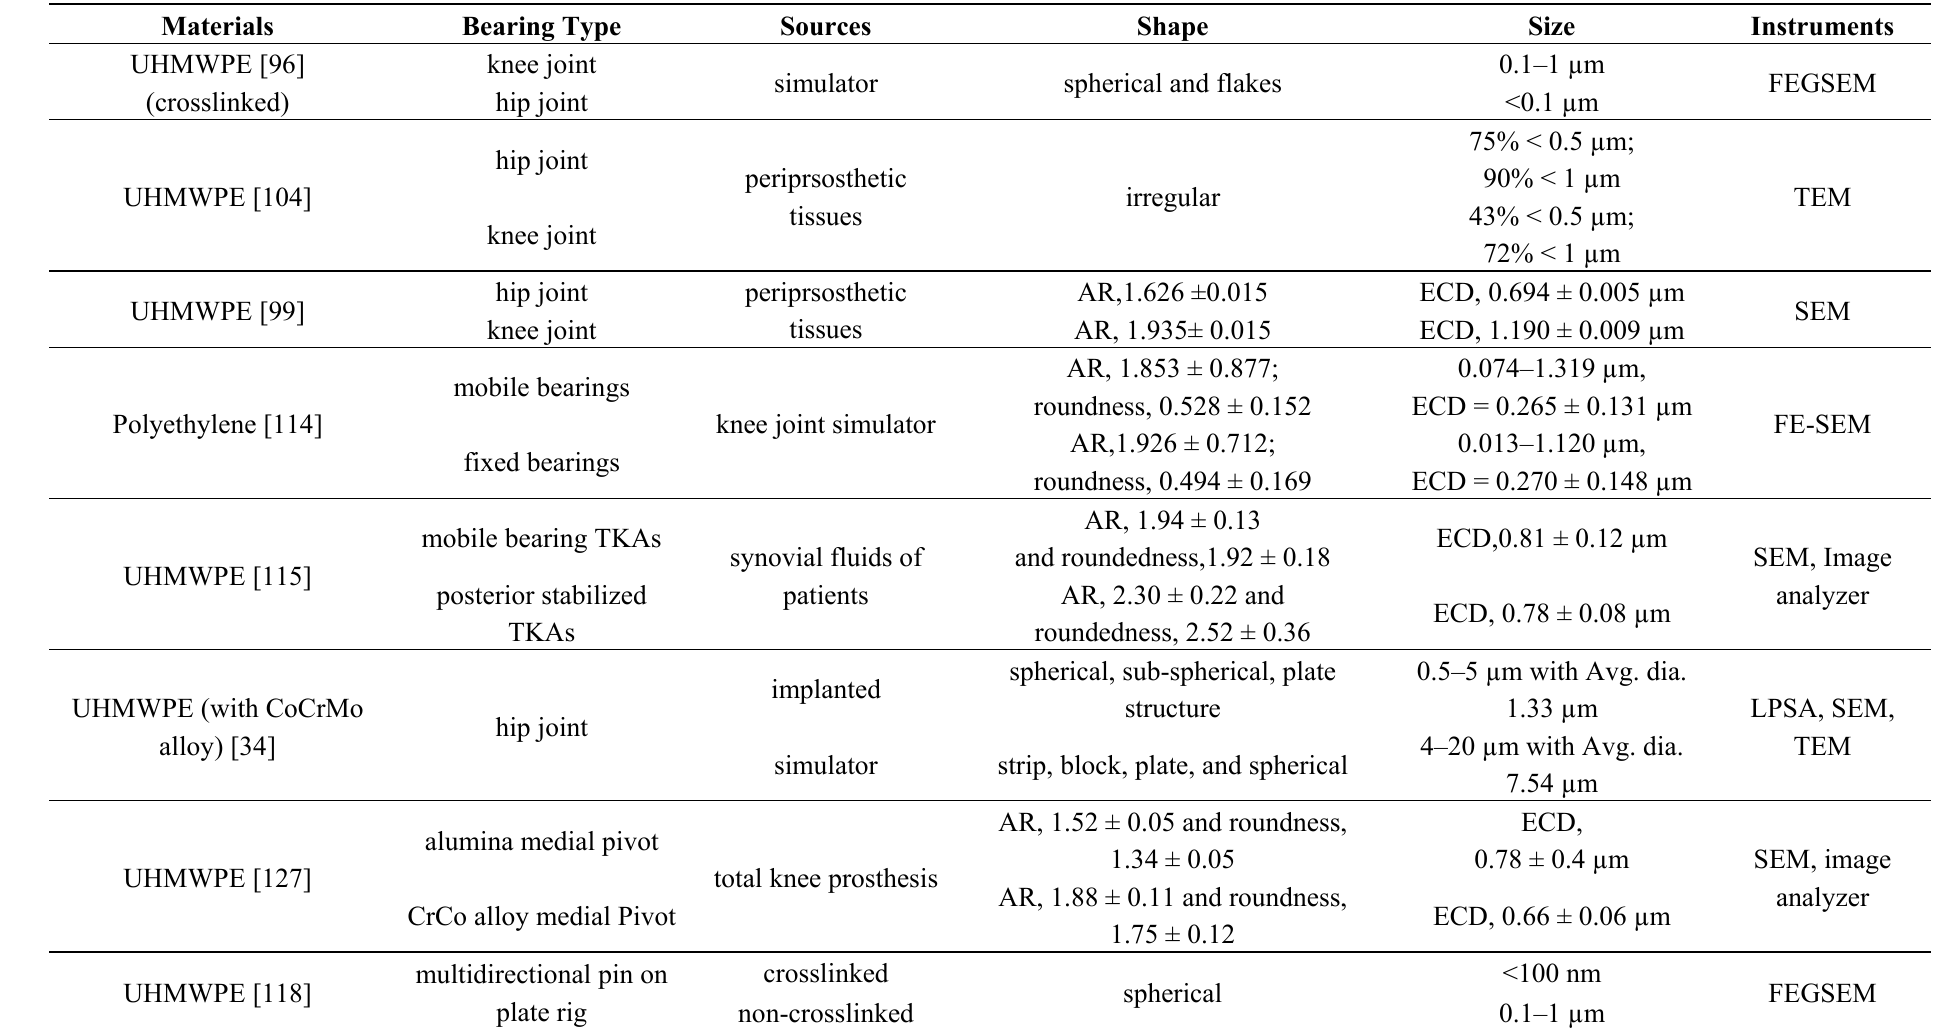
Table 2. Characterization of Polyethylene wear debris from different types of